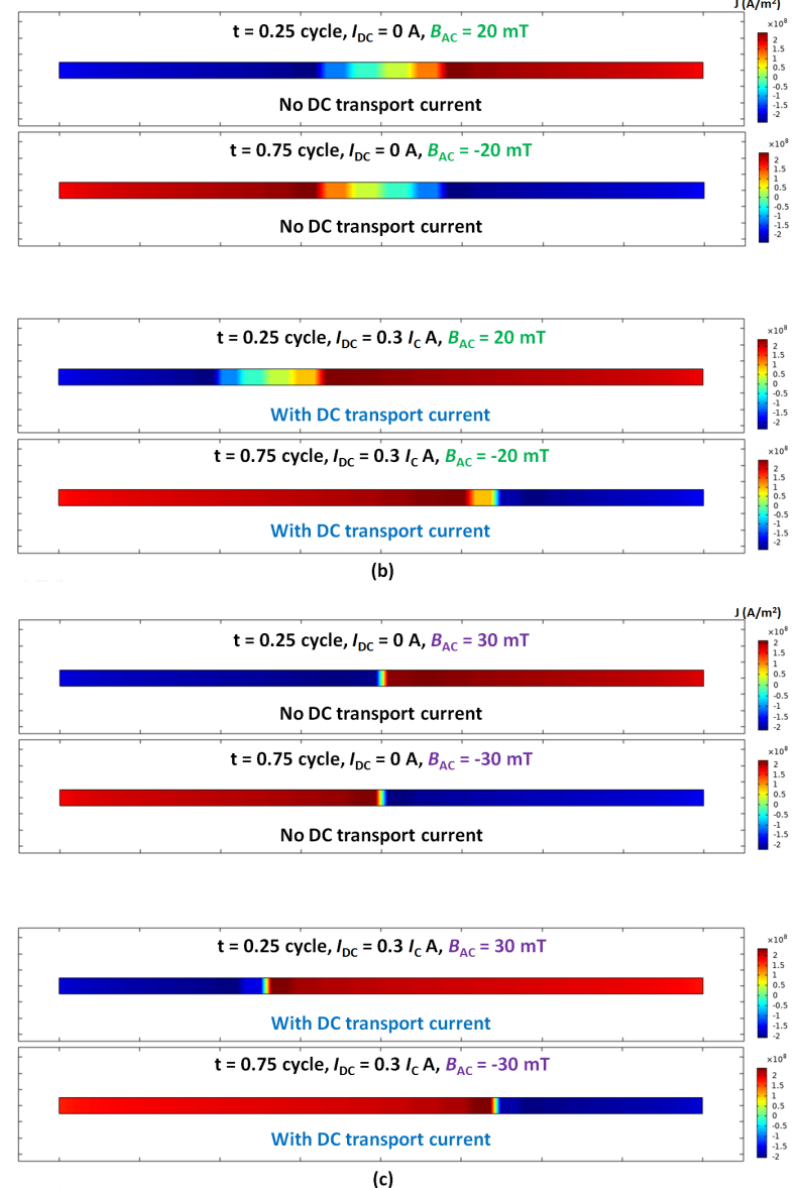
Figure 4. ‘No DC transport current’ vs. ‘with DC transport current’: current density distribution of an HTS tape (4 mm width and 1 µ m thickness, but here thickness was visually expended × 100 times for better observation), at the time point t = 0.25 cycle and t = 0.75 cycle, with a sinusoidal AC magnetic field perpendicular subject to the HTS tape, with the peak values ( a ) 10 mT, ( b ) 20 mT and ( c ) 30 mT.